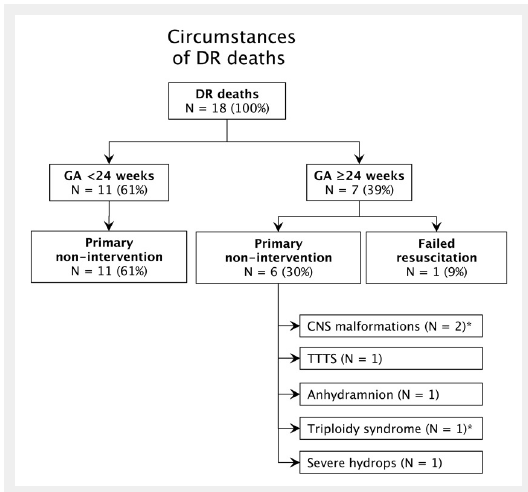
ELGAN patient population cared for at the Children’s Hospital of Lucerne between 2000 and 2009: DR and NICU mortality, survival and neuro-developmental follow-up rates. * After exclusion of one ELGAN with trisomy 21.